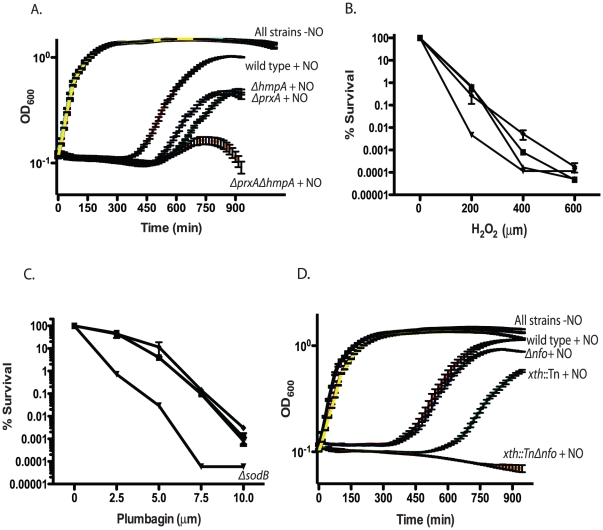
Growth of RNS/ROS mutants under stress.A. Nitric oxide stress. Exponentially growing cultures of wild type V. cholerae, the ΔhmpA mutant, ΔprxA mutant or ΔprxA ΔhmpA double mutant were grown with or without 1 mM spermine NONOate as a nitric oxide donor. The recovery and growth of each strain was monitored over time. The averages of 3 experiments are shown for each strain. Curves for wild type, ΔhmpA, ΔprxA and ΔprxA ΔhmpA double mutant treated with spermine NONOate are labeled as “+NO” for clarity. All strains grown in LB without spermine NONOate cluster together and are shown on the plot with the label “All strains−NO”. wild type+NO (red), ΔhmpA+NO (green), ΔprxA+NO (blue), ΔprxA ΔhmpA+NO (orange), wild type−NO (black), ΔhmpA−NO (purple), ΔprxA−NO (cyan) and ΔprxA ΔhmpA−NO (yellow). The growth of the ΔprxA, ΔhmpA and ΔhmpA ΔprxA mutant is significantly delayed by NO compared to wild type by 435 min (p<0.05). B. H2O2 sensitivity. Wild type (▪) and katB::Tn (▴), perA::Tn (▾) and ahpC::Tn (♦) mutants were plated on increasing concentrations of hydrogen peroxide. Cfu were determined after overnight growth. The average of 3 experiments is shown. C. Superoxide sensitivity. Wild type (▪) and sodA::Tn (▴), ΔsodB (▾) and sodC::Tn (♦) mutants were plated on agar containing increasing concentration of the superoxide generating compound plumbagin. Cfu were determined after overnight growth. The average of 3 experiments is shown. D. Exponentially growing cultures of wild type, the xth::Tn mutant, Δnfo mutant or xth::Tn Δnfo double mutant were grown with or without 1 mM spermine NONOate as a nitric oxide donor. The recovery and growth of each strain was monitored over time. The averages of 3 experiments are shown for each strain. Curves for wild type, xth::Tn, Δnfo and xth::Tn Δnfo treated with spermine NONOate are labeled as “+NO” for clarity. All strains grown in LB without spermine NONOate cluster together and are shown on the plot with the label “All strains−NO”. wild type+NO (red), xth::Tn+NO (green), Δnfo+NO (blue), xth::Tn Δnfo+NO (orange), wild type−NO (black), xth::Tn−NO (purple), Δnfo−NO (cyan) and xth::Tn Δnfo−NO (yellow). At 750 min the growth delay of the xth::Tn mutant compared to the wild type in NO is significant (p<0.001) while the growth delay of the Δnfo mutant is not.